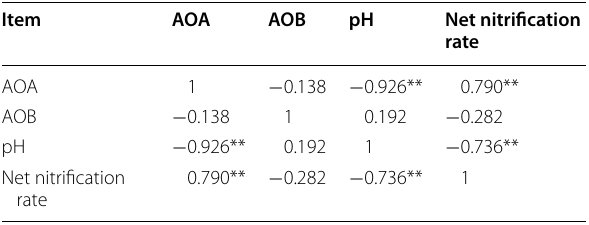
Table 2 Pearson correlation between target gene copies, pH and net nitrification rate